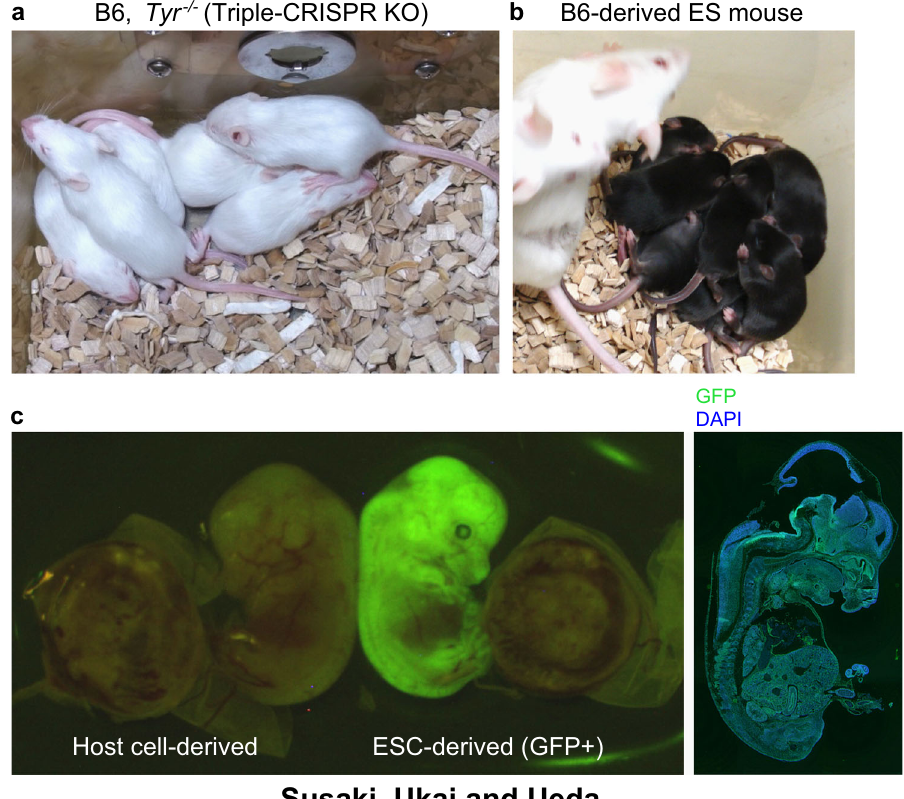
Fig. 3 One-step generation of genome-edited mice. a An example of triple-CRISPR KO littermates (before weaning) in B6 strain. Tyr gene coding tyrosinase (an enzyme involving black coat color) was knocked out by the triple-CRISPR method. 62 All littermates had white coat color, indicating ~100% bi-allelic KO rate of the targeted gene. b An example of B6 ES mouse littermates (before weaning) by 3i + LIF culture and 8- cell injection. 141 All littermates had black coat color, indicating ef fi cient generation of ~100% ESC-derived mouse. c An ES mouse embryo (E13.5) derived from an H2B-EGFP KI ESC clone. 170 Only the embryo (but not the extraembryonic tissues) expresses EGFP, suggesting the unique contribution of ESC-derived cells. Entire section of the ES mouse is shown in the right panel. All animal experiments here